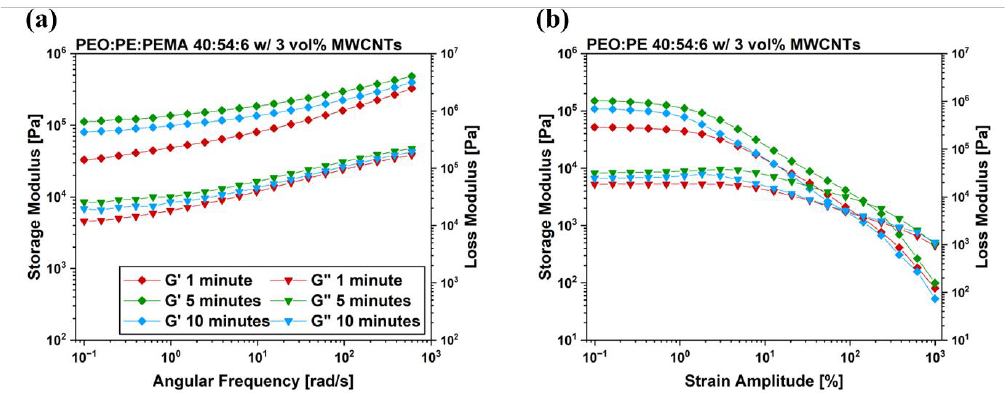
Figure 10. ( a ) Frequency sweep and ( b ) strain sweep results for PEO/PE 40:54:6 blends containing 3 vol% MWCNTs.